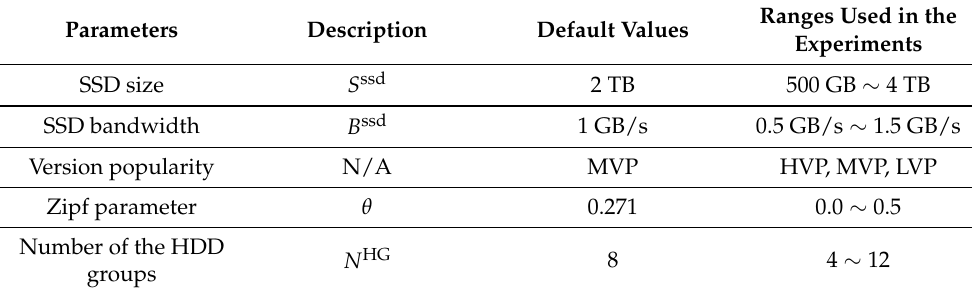
Table 3. Parameter settings for